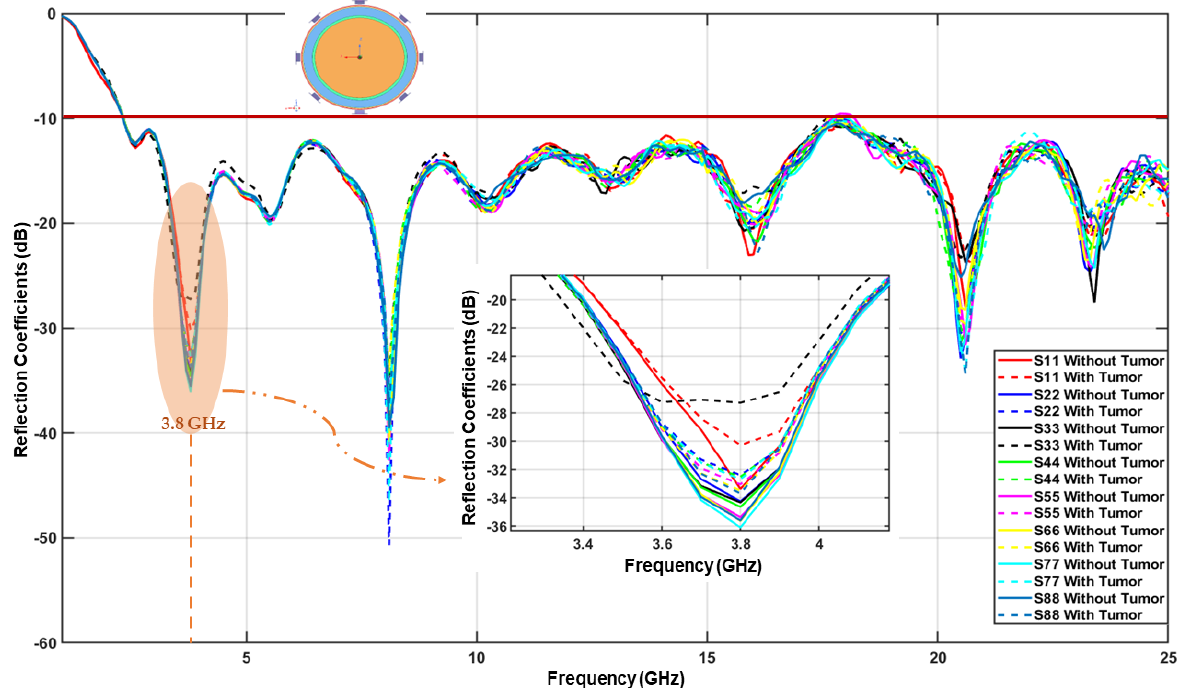
Figure 8. Comparison between reflection coefficients of healthy and unhealthy phantoms when a 5 mm radius tumor is placed in the phantom’s center.